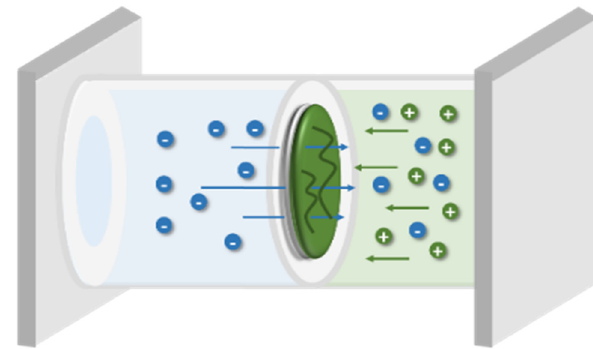
Figure 5: Illustration of the two - compartment cross fl ow reactor.